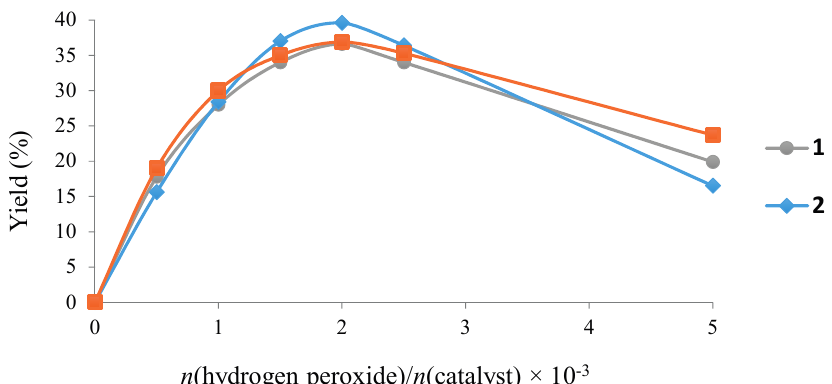
Figure 4. Dependence of the overall yield (mol %, based on substrate) of the products (cyclohexanol + cyclohexanone) on the amount of oxidant (H 2 O 2 , molar ratio relatively to 1 (  ), 2 (  ) or 3 (  )) in the oxidation of cyclohexane. Reaction conditions: n (H 2 O 2 )/ n (catalyst) (0–5 × 10 3 ), cyclohexane (5.0 mmol), r.t., 10